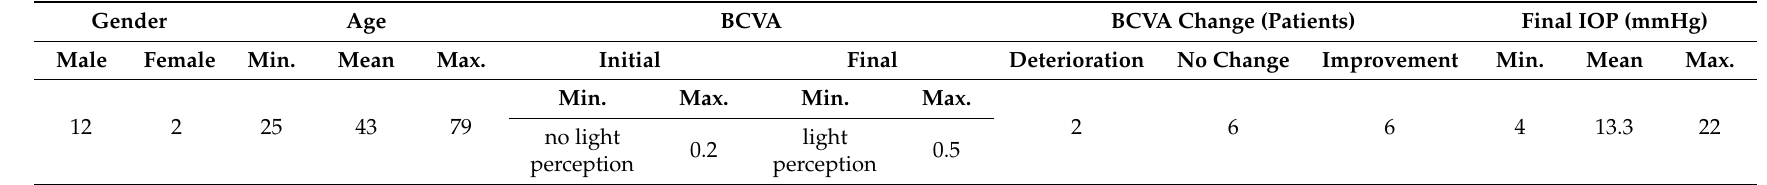
Table 2. Demographics, best corrected visual acuity (BCVA) and IOP